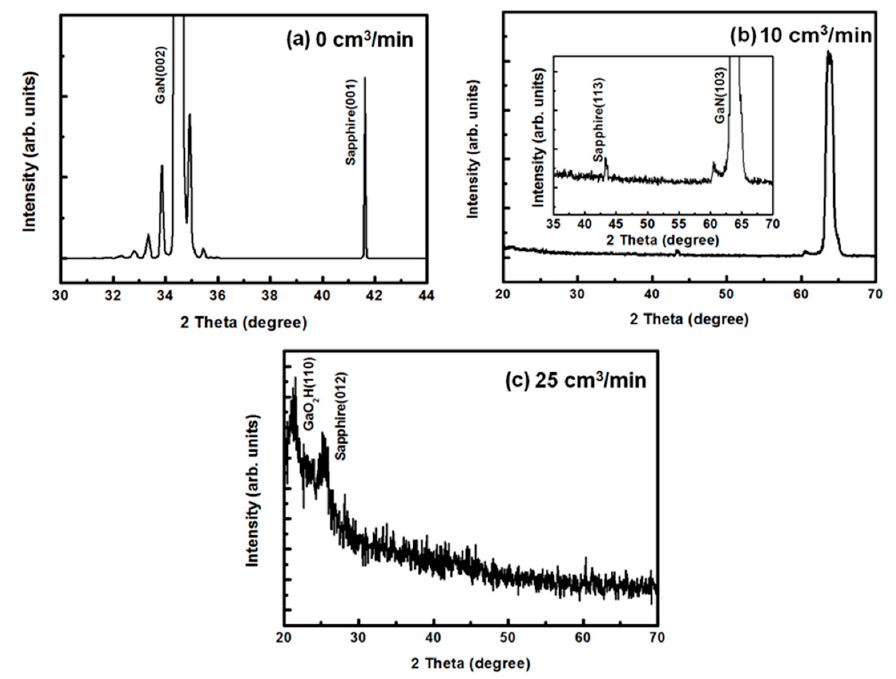
Figure 4. XRD spectra of the GaN-epi/PSSs decomposed at 1200 °C for 3 h under gas-flow rates of ( a ) 0 cm 3 /min, ( b ) 10 cm 3 /min, and ( c ) 25 cm 3 /min.